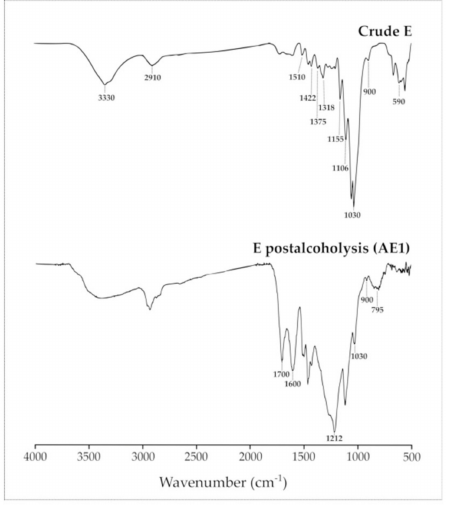
Figure 6. FT-IR spectra registered in ATR mode for the starting cardoon E sample and that of the solid residue recovered after alcoholysis reaction